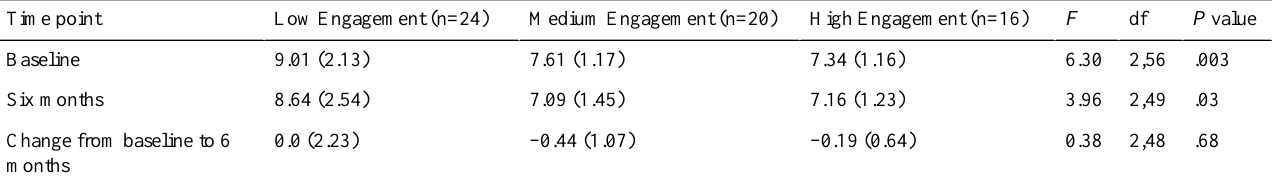
Table 6. Hemoglobin A 1c levels (mean, SD) at baseline, 6 months, and change according to multitrajectory engagement group